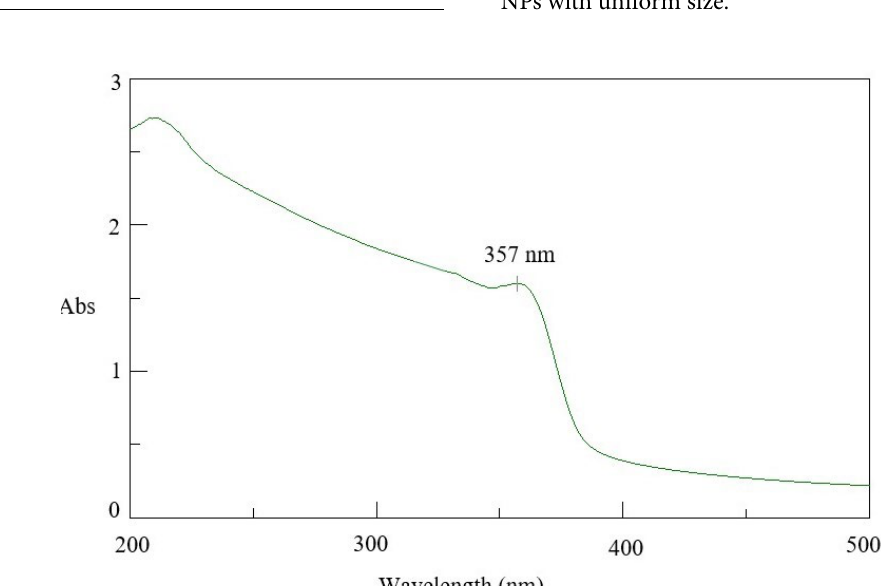
Figure 6. UV-Vis absorption spectra of synthesized ZnO NPs.